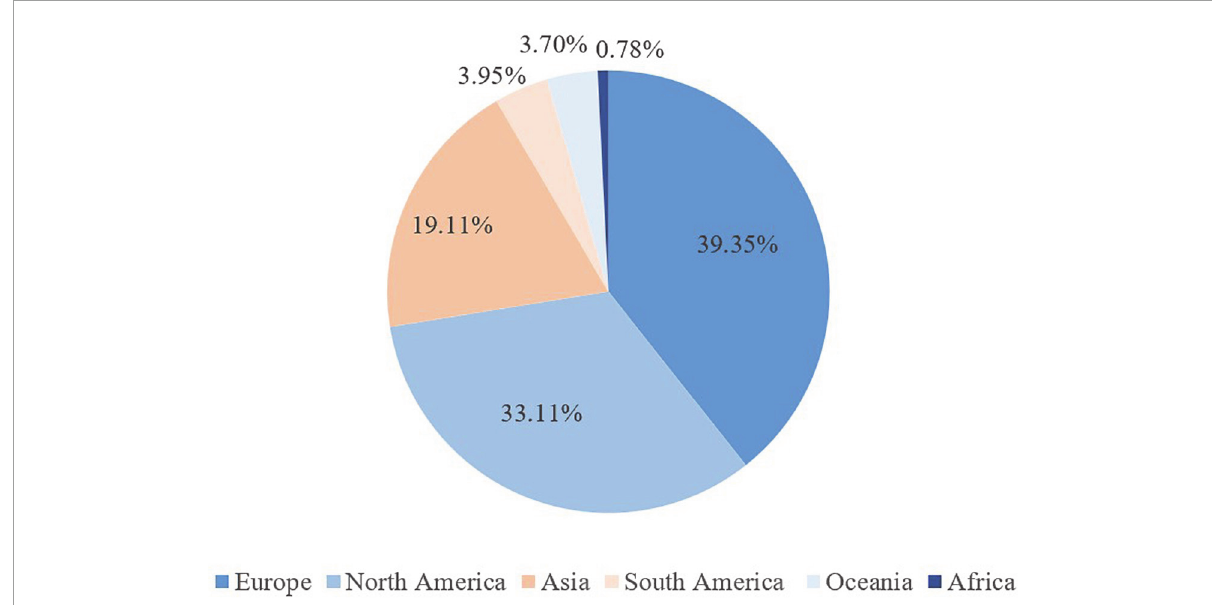
FIGURE3 Proportion of menopausal hormone therapy (MHT)-related publications in terms of regions.